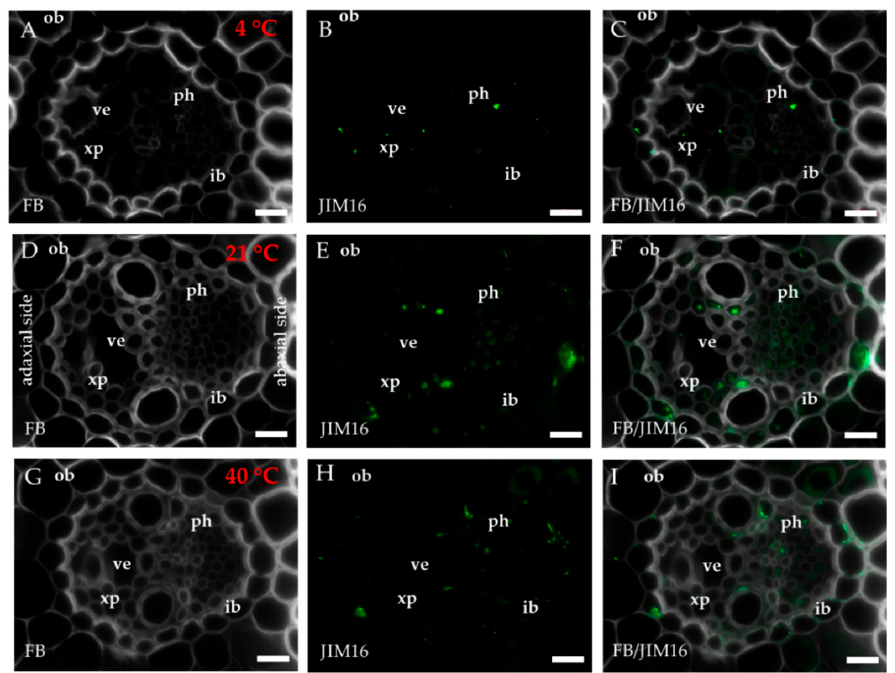
Figure 3. Immunolocalisation of the JIM16 epitope ( A – I ) in cross ‐ sections of the B. distachyon leaves, (A ‐ I): through the major vascular bundle. ( A – C ): 4 °C; ( D – F ): 21 °C; ( G – I ): 40 °C. Abbreviations: FB— fluorescent brightener, ib—inner bundle sheath, ob—outer bundle sheath, ph—phloem, ve—vessels, xp—xylem parenchyma. The green colour shows epitope occurrence. Scale bars: 10 μ m.